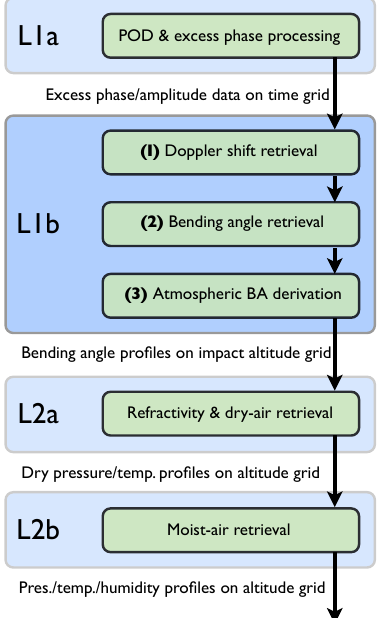
Figure 1. Schematic view of the main processors of the retrieval chain in the rOPS (L1a, L1b highlighted, L2a, L2b) and the main operators of the L1b processor (1, 2, 3), which are in the focus of this